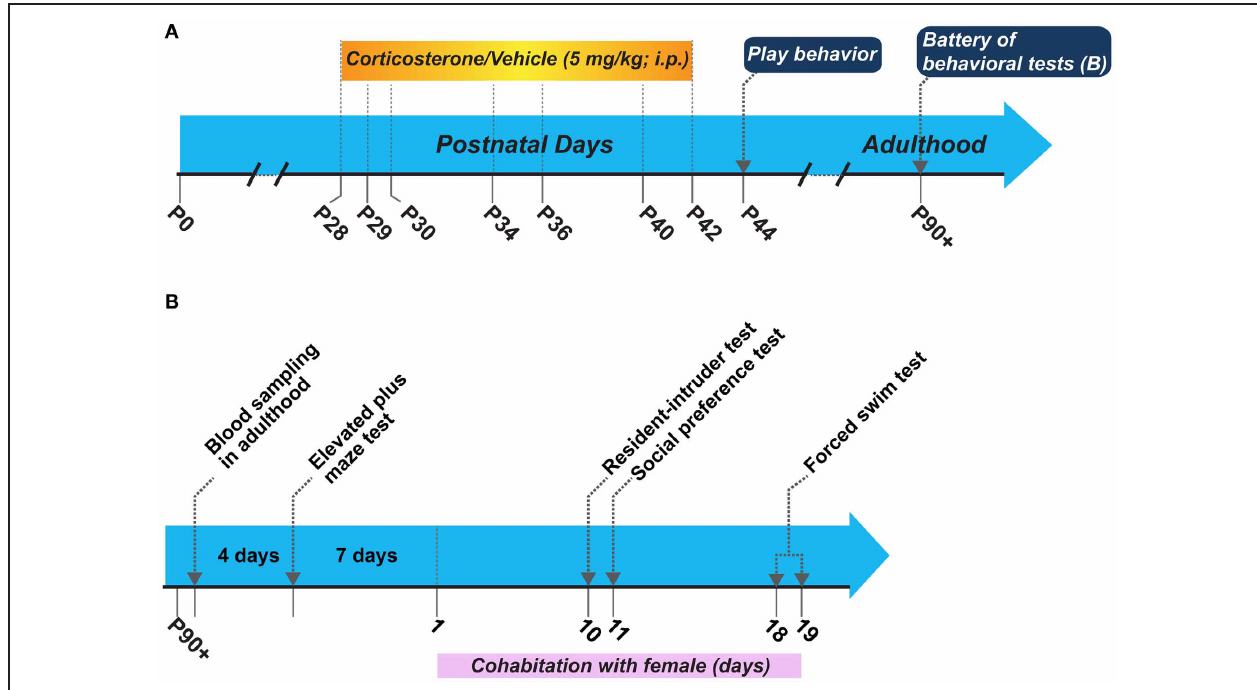
FIGURE 1 | (A) Schematic of the general experimental design, and (B) Sequence of behavioral tests performed in adulthood. P, postnatal